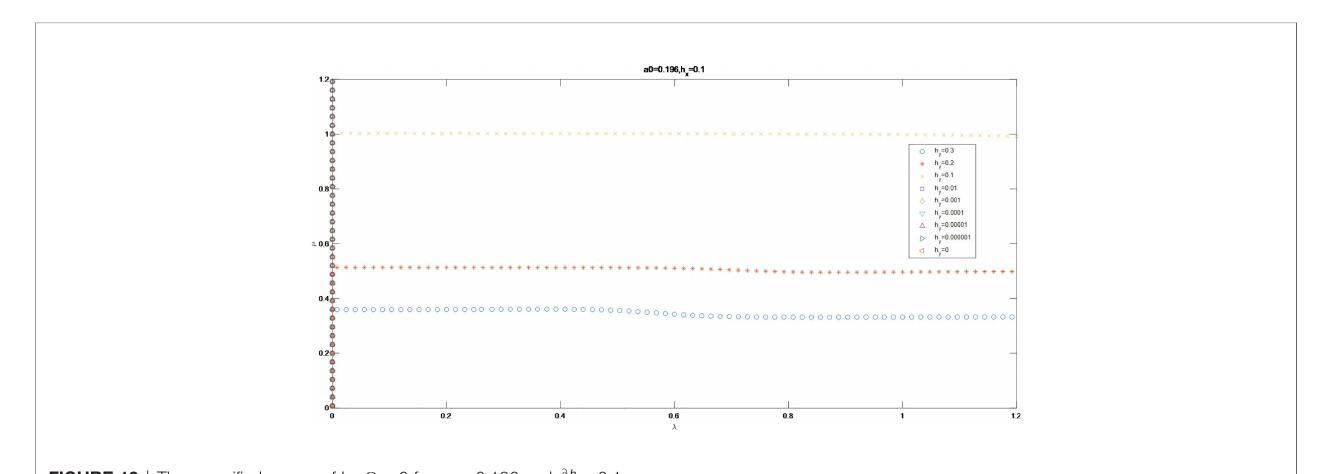
FIGURE 12 | The magni fi ed curves of Im W = 0 for a 0 = 0.196 and ∂ h ∂ x = 0 : 1.